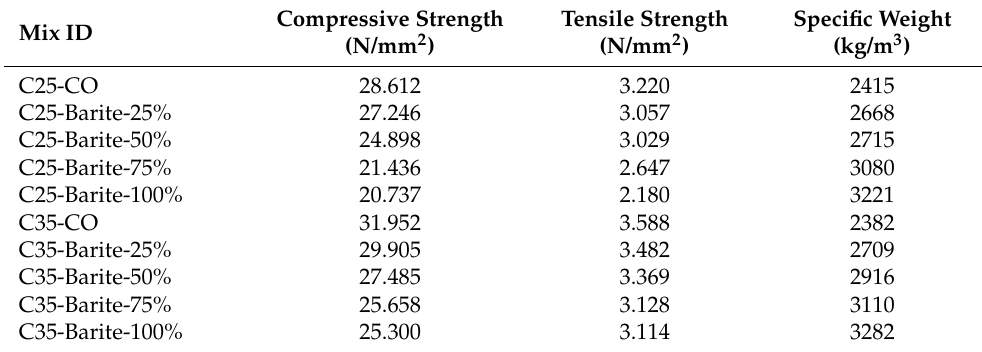
Table 5. Results of compressive and tensile strength tests and unit weight of the samples with different mixture designs.